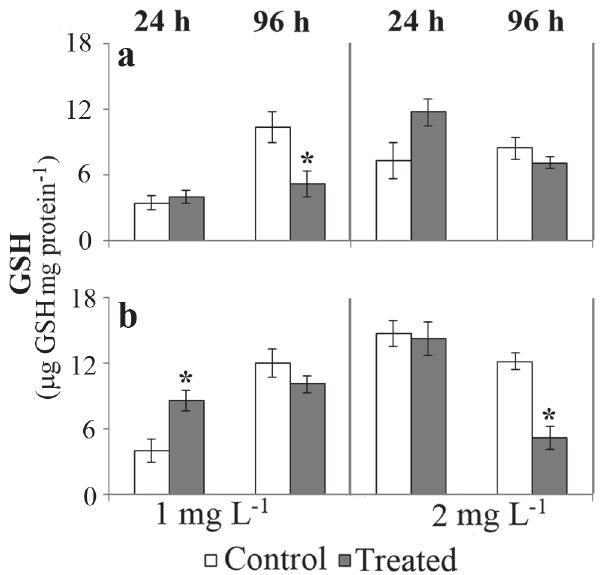
Fig. 6. Comet scores of DNA damage in erythrocytes ( a ) and branchial cells ( b ) of Prochilodus lineatus exposed to 1 or 2 mg L -1 lyophilized Microcystis aeruginosa (treated) or only water (control), for 24 and 96 h. Values are presented as mean ± SEM (n = 4-8). Asterisks indicate significant differences when compared to respective control (p <